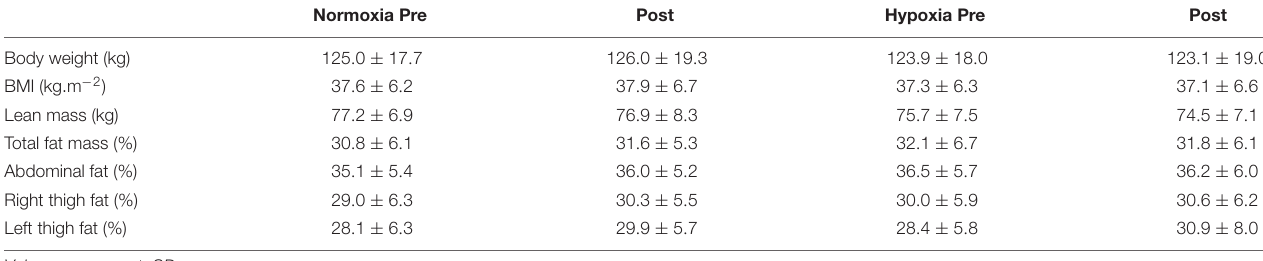
TABLE 1 | Anthropometric variables before (PRE), and at the end (POST) of the 10-day NORMOXIC and HYPOXIC trials. Normoxia Pre Post Hypoxia Pre